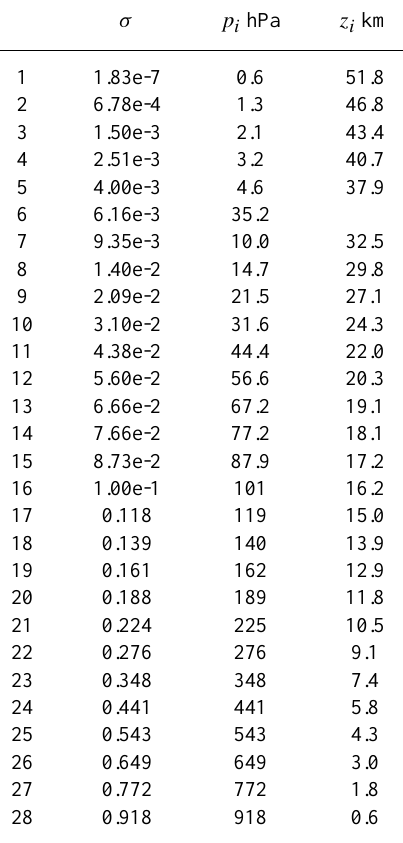
Table 1. Sigma levels of the